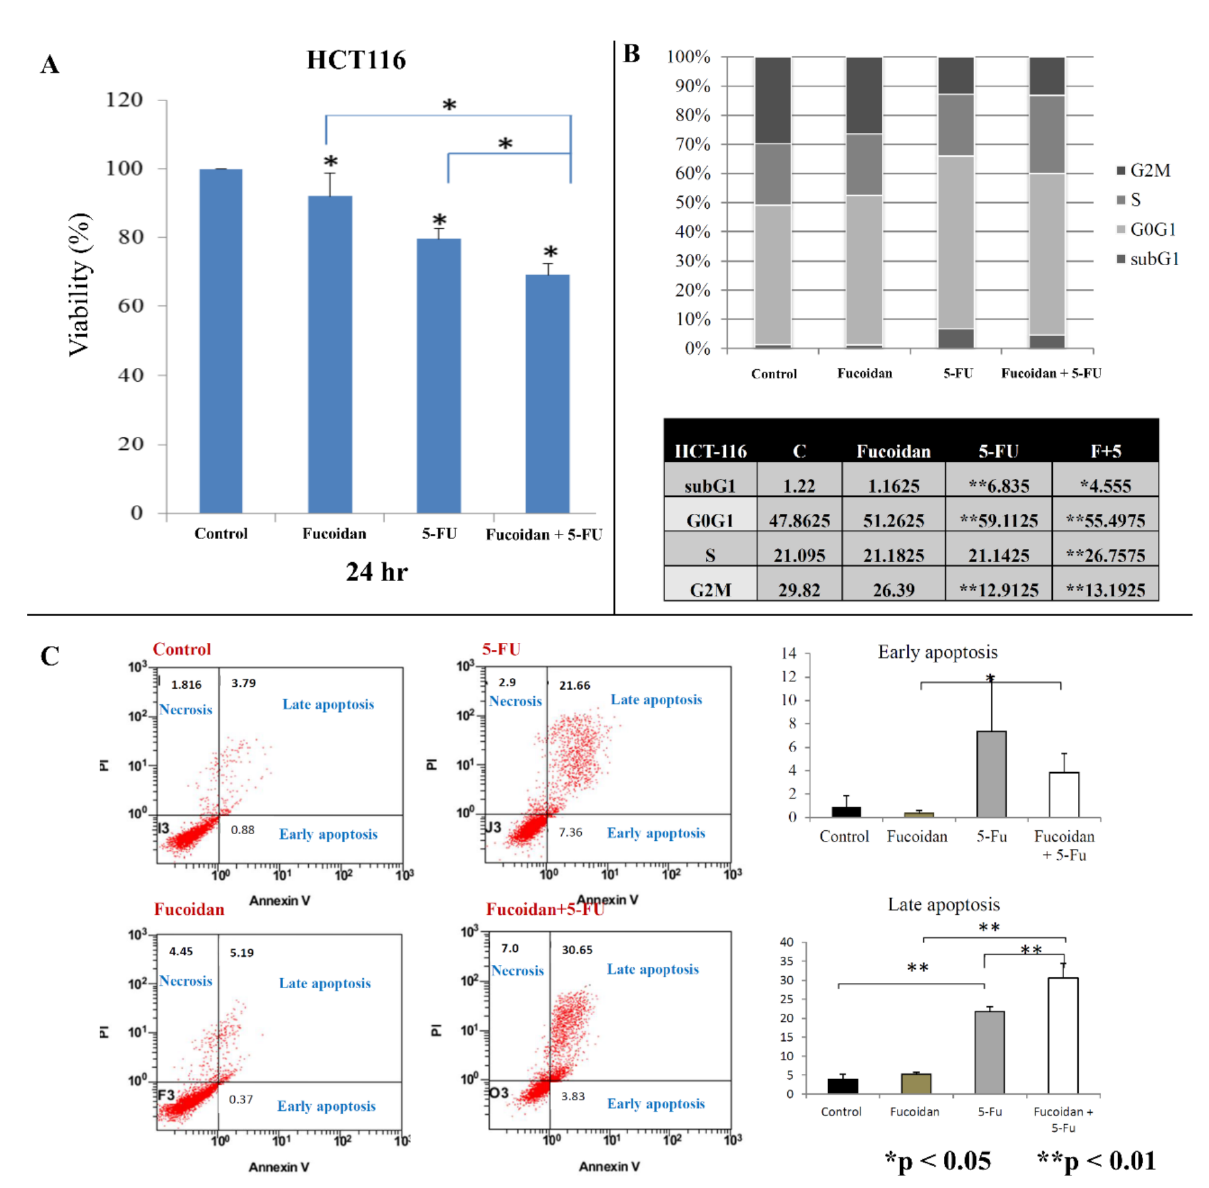
Figure 1. Effects of LMWF and 5-fluorouracil (5-FU) on viability, cell cycle, and apoptosis status of HCT116 cells: ( A ) cell viability of HCT116 cells at 24 h; ( B ) cell cycle of HCT116 cells; ( C ) cell apoptosis of HCT116 cells. Data are presented as the mean of three independent experiments. * p < 0.05; ** p <